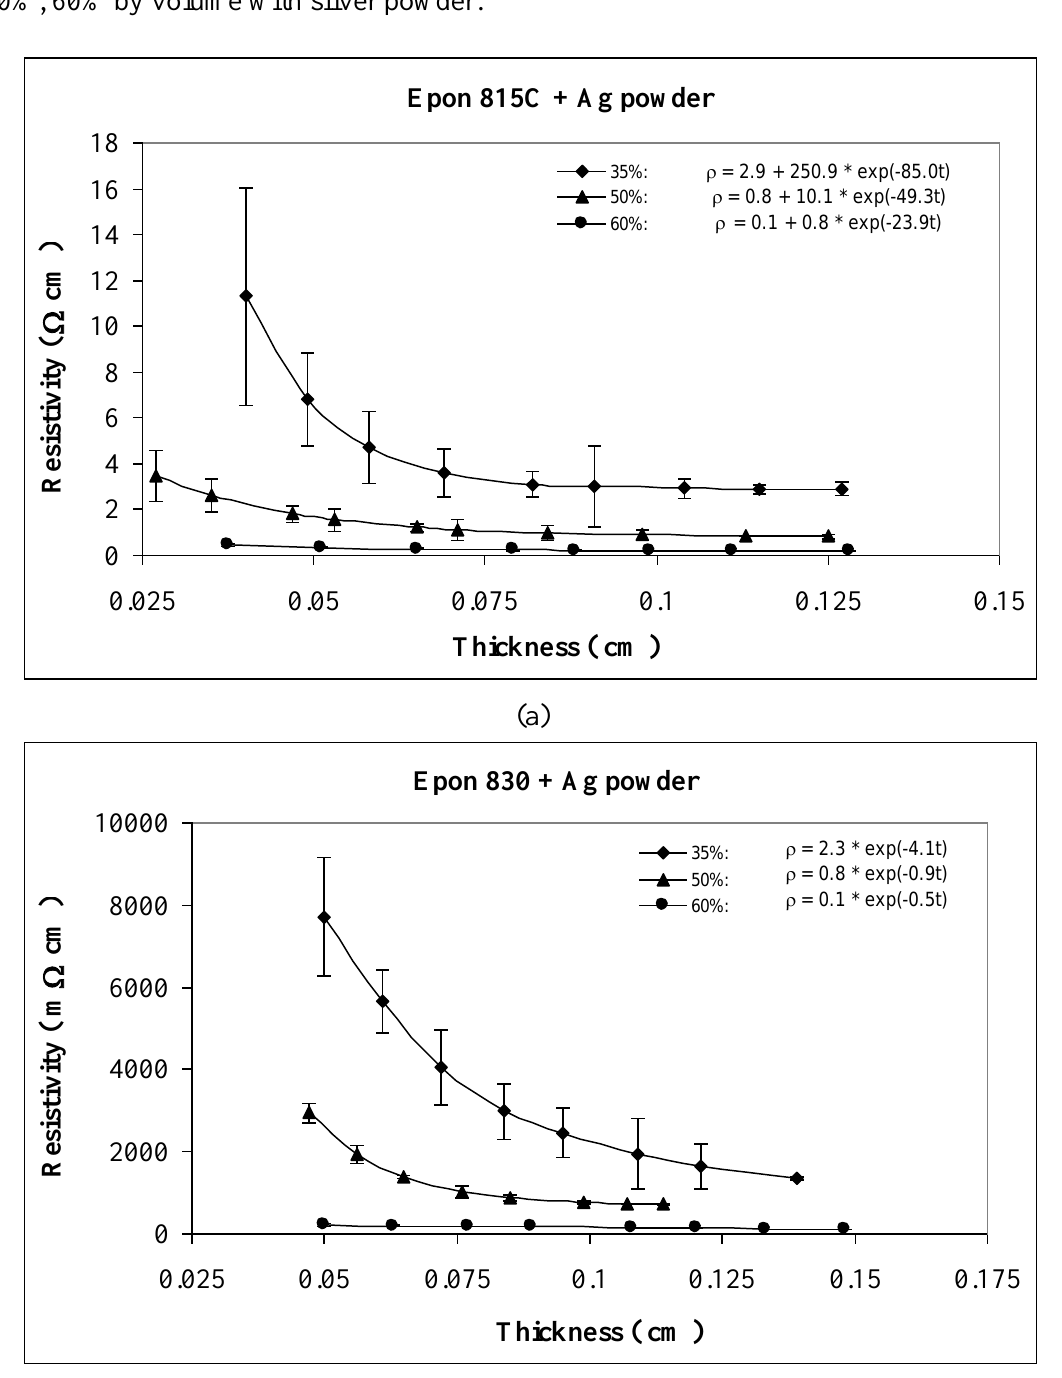
Figure 7. Thickness-dependent resistivity of Epon 815C ( a ), and 830 ( b ) films filled 35%, 50%, 60% by volume with silver